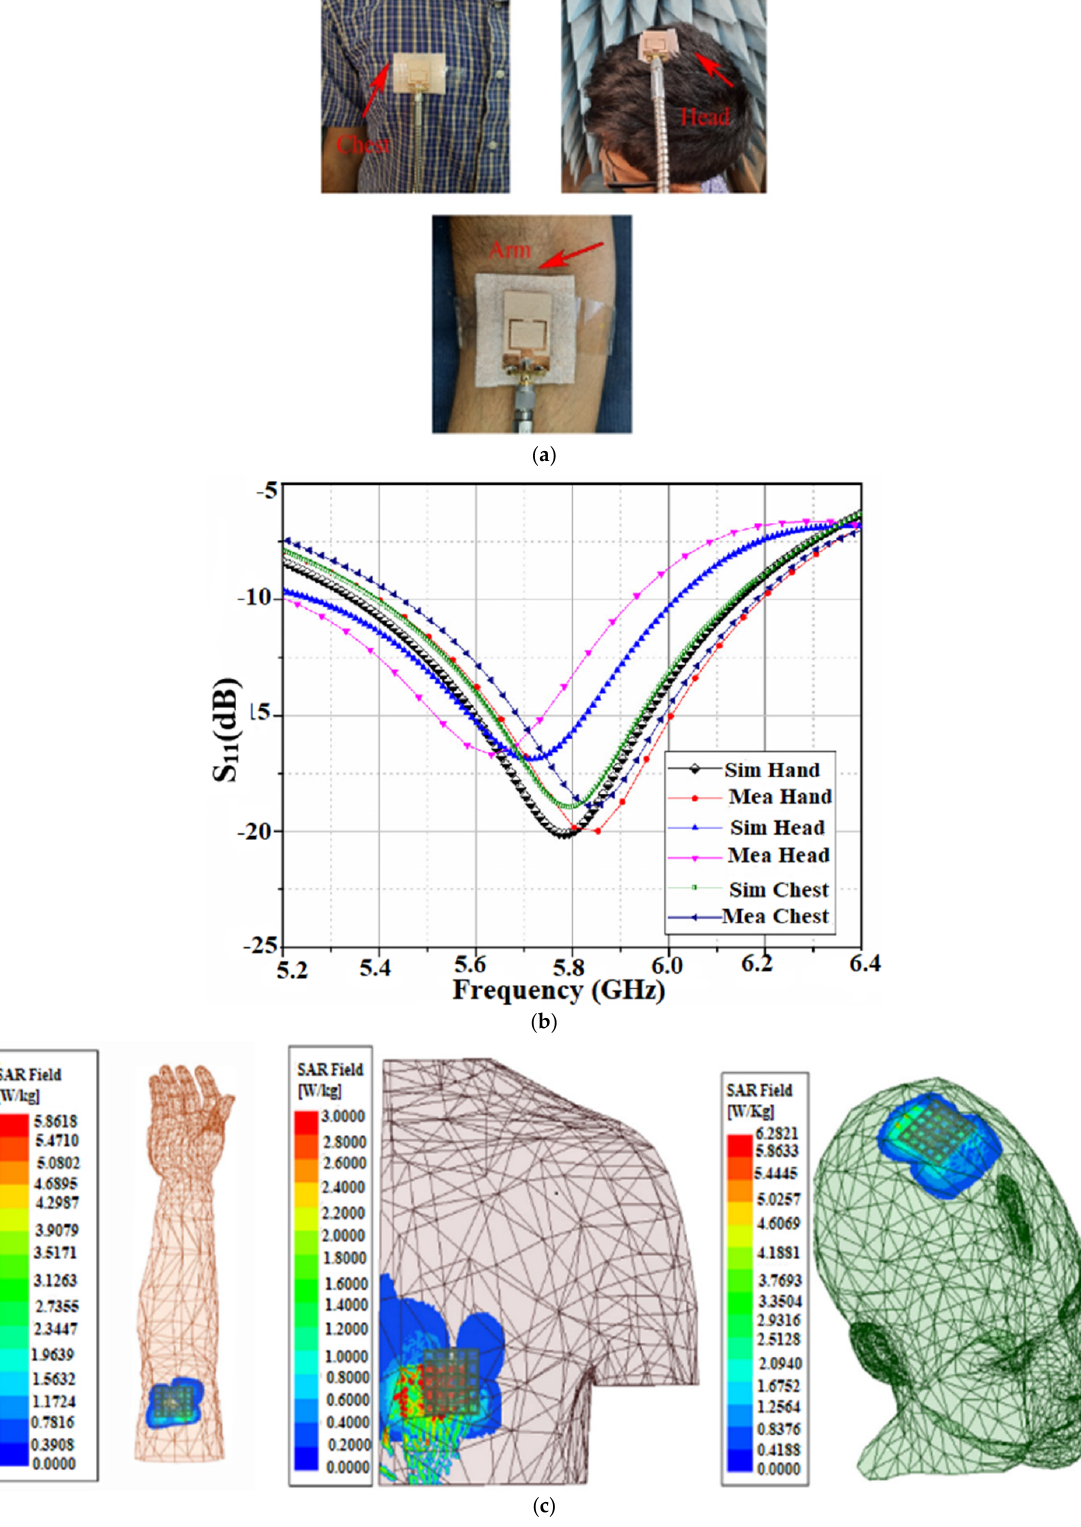
Figure 5. Relevance of the SAR on the design of a flexible antenna: ( a ) AMC-backed antenna on various parts of the body; ( b ) Reflection coefficient behavior on the human body; ( c ) SAR of the antenna on different parts of the human body — hand, chest, and head. Reprinted from ref. [44] .